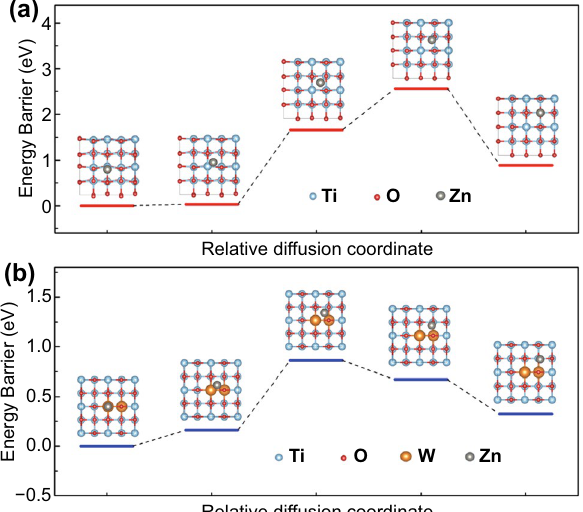
Fig. 4 DFT calculations. The diffusion energy curves of isolated Zn 2+ from one stable position to a neighboring one in the a TiO 2 and b doped TiO 2 with a W content of 4.2%. Insets show the possible Zn 2+ insertion sites in TiO 2 and W-doped TiO 2 during the diffusion